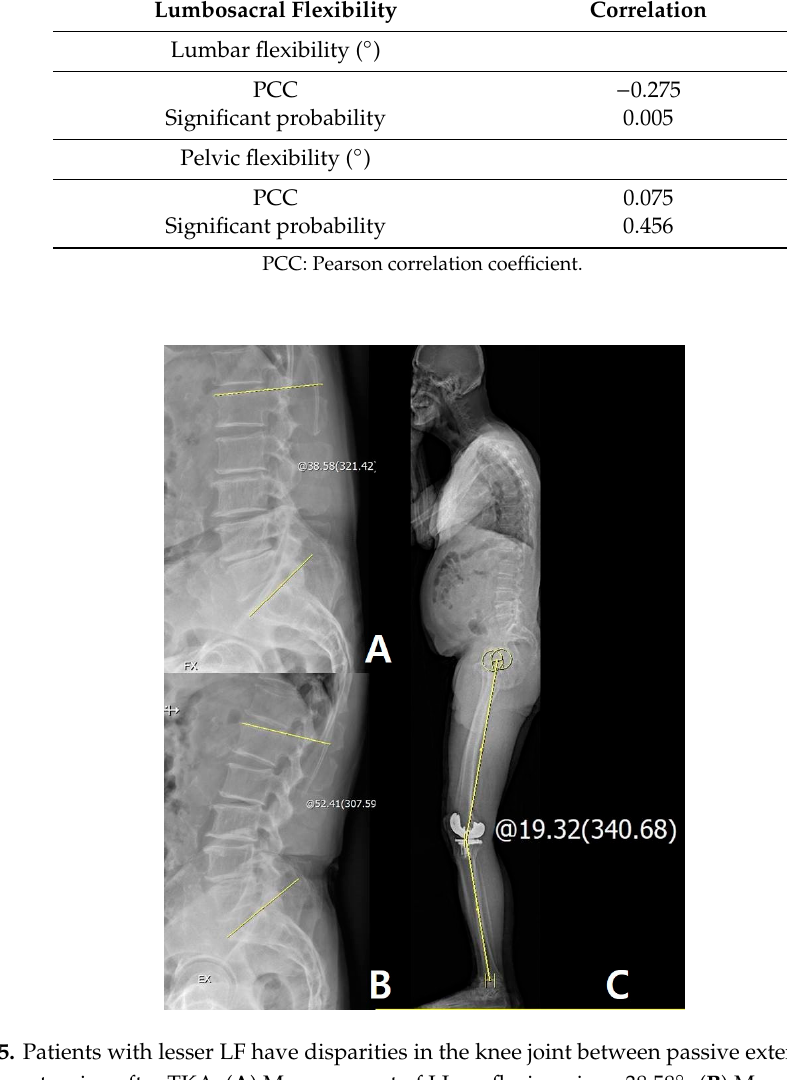
Table 5. Correlation analysis between disparity and lumbosacral flexibility.